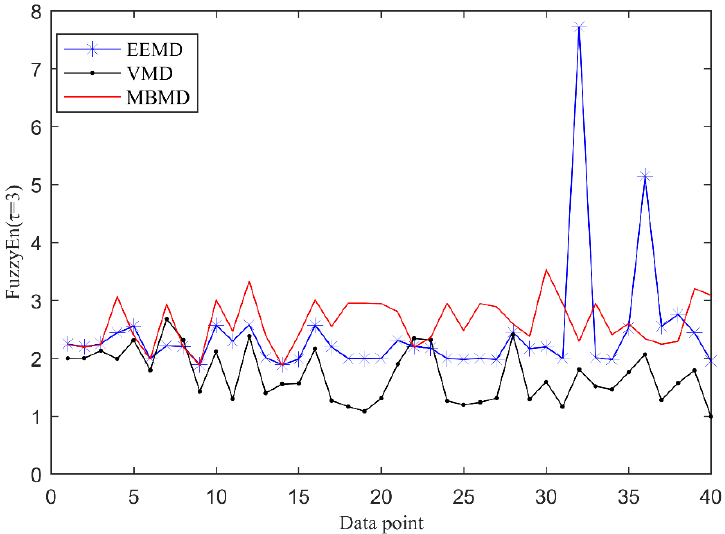
Figure 24. MBMD, VMD, EEMD comparison diagram of the harmonic signal.